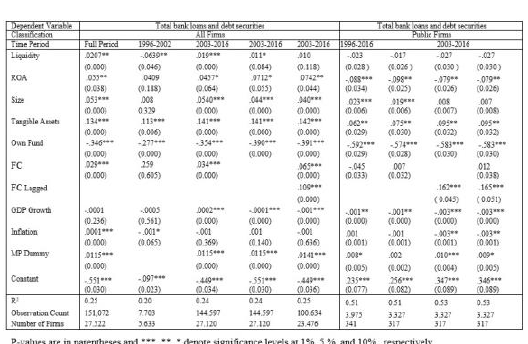
Table 4: Fixed Effect Analysis on Financial Debt